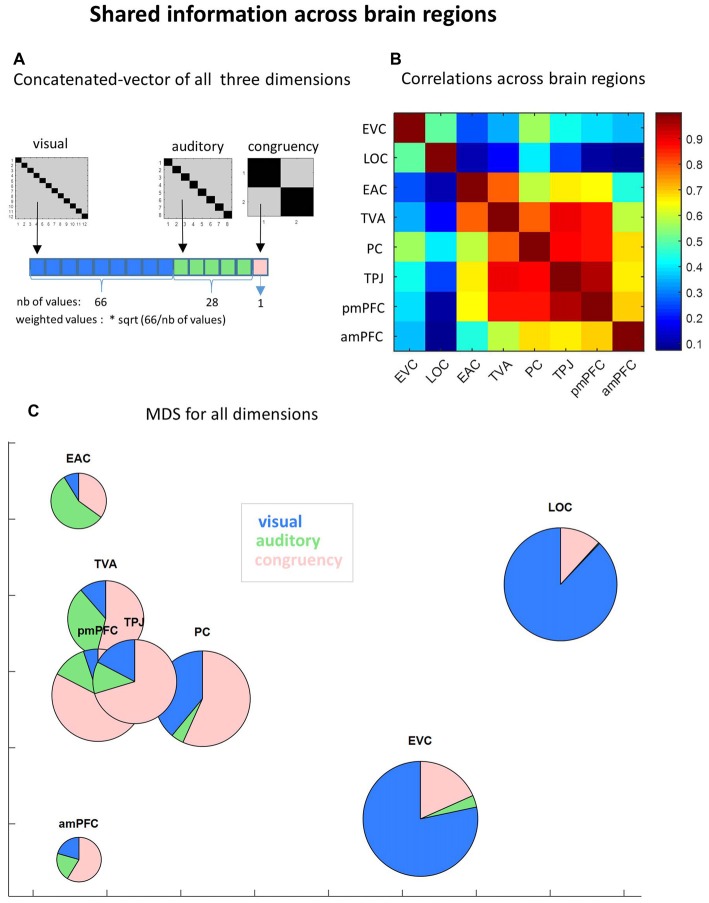
Shared information across brain regions.(A) Concatenated vector of all three dimensions. To evaluate how information was shared across brain regions, we built a concatenated vector from the neural similarity matrices of the three manipulated dimensions (visual, auditory and congruency), using only non-diagonal cells (upper and lower triangles averaged). Each dimension vector was weighted to compensate for the different number of values. (B) Correlation across brain regions. Pairwise Pearson correlations across brain regions were performed using the group average concatenated vector. (C) MultiDimesional Scaling (MDS) for all dimensions. MDS was applied (1000 iterations) to the same concatenated vectors to verify the clustering of ROIs based on common information. To visualize the specific informational content of each ROI we plotted pies instead of dots, showing the relative contribution of each dimension (diagonal minus non-diagonal). Pies are scaled in proportion to the total amount of information (sum of diagonal minus non-diagonal in all experimental dimensions).